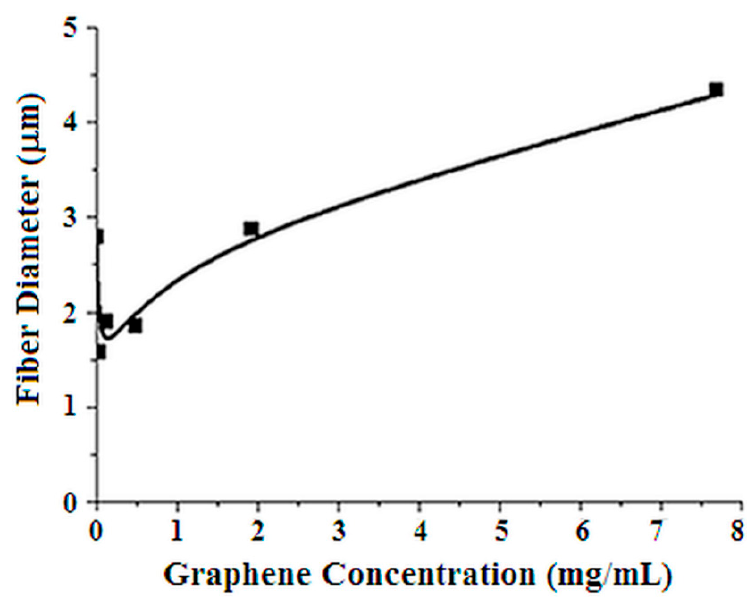
Figure 7. Plot of fibre diameter as a function of graphene content in the electrospun solution.